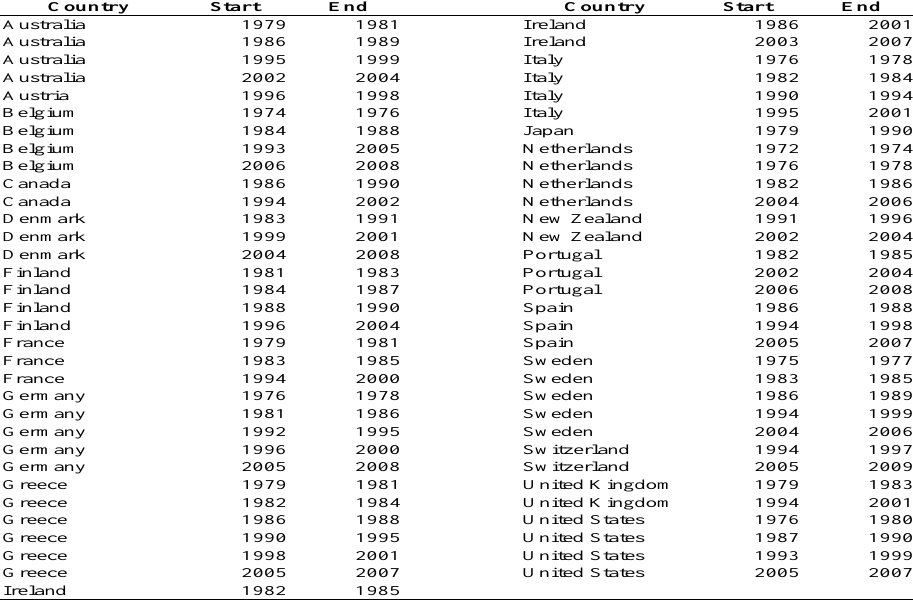
Table 2: Dates of consolidation episodes